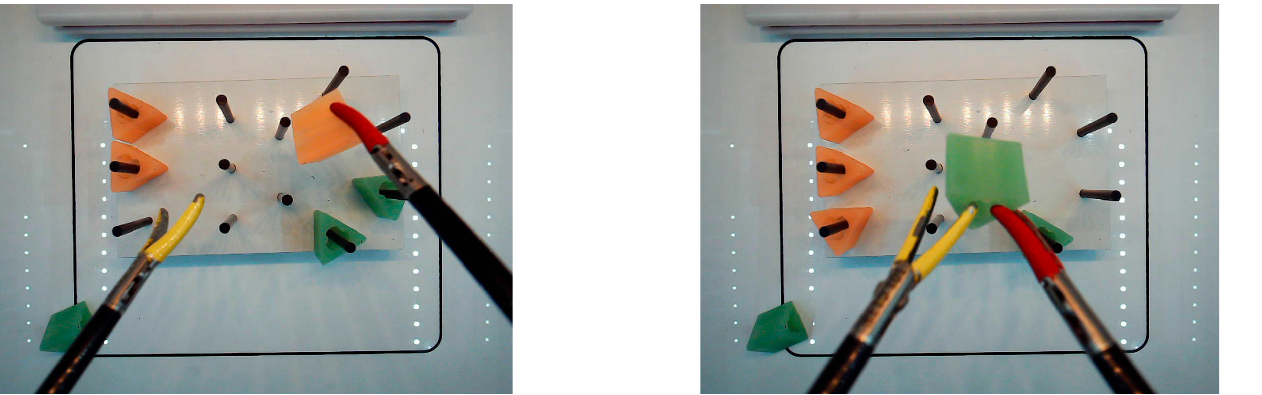
Figure 1. Pegboard with 12 pegs, and six ring-like objects (triangles) in the IBTS.